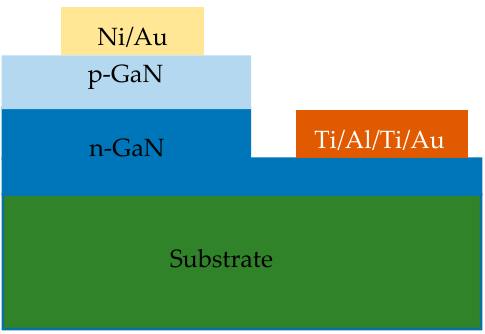
Figure 4. Cross-sectional schematic of GaN p-n diodes for α -particle detectors.